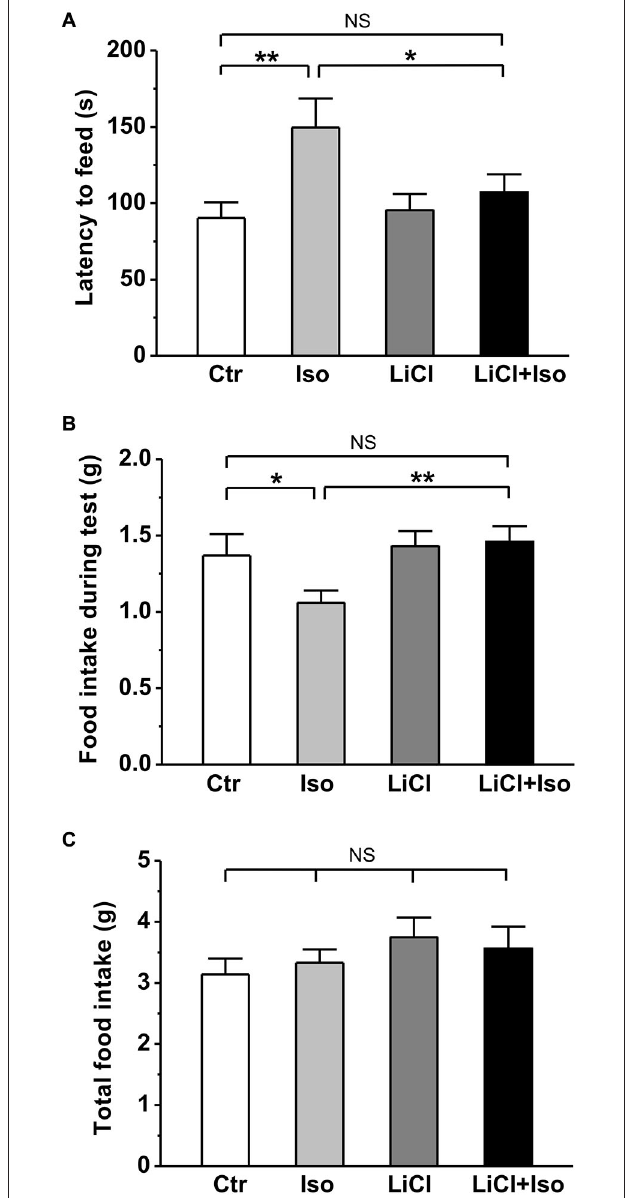
FIGURE 4 | Lithium reduces neonatal isolation-induced anxiety-like behavior in the novelty-suppressed feeding test . The feeding latency (A) is significantly increased; while the amount of food intake (B) is significantly reduced in isolated rats compared to control. Lithium treatment reinstates this behavior. (C) No differences are observed in total food consumption including during test and in home cage among these groups. Two-way ANOVA analysis was used in this experiment. For latency to intake: treatment × drug, F ( 1,74 ) = 3.064, P > 0.05; treatment, F ( 1,74 ) = 6.901, P < 0.05; drug, F ( 1,74 ) = 1.900, P > 0.05. For food intake during test: treatment × drug, F ( 1,74 ) = 2.608, P > 0.05; treatment, F ( 1,74 ) = 5.022, P < 0.05; drug, F ( 1,74 ) = 1.946, P > 0.05. For total food intake: treatment × drug, F ( 1,74 ) = 0.405, P > 0.05; treatment, F ( 1,74 ) = 0.001, P > 0.05; drug, F ( 1,74 ) = 1.941, P > 0.05. Data show mean ± SEM (* p < 0.05; ** p <